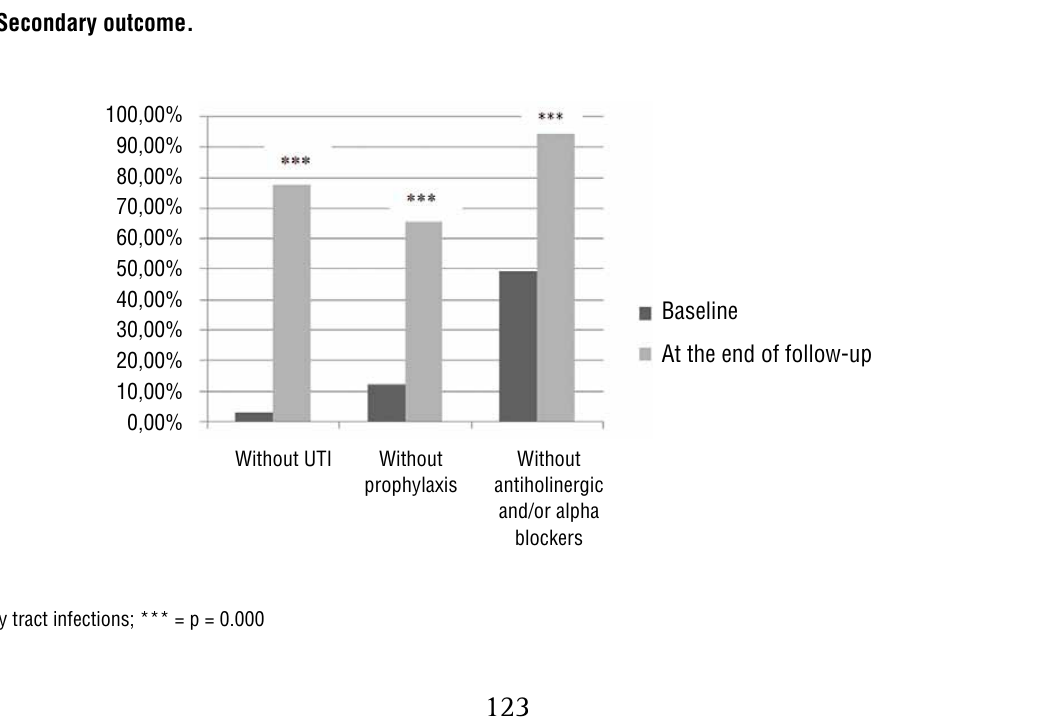
Figure 3 - Secondary